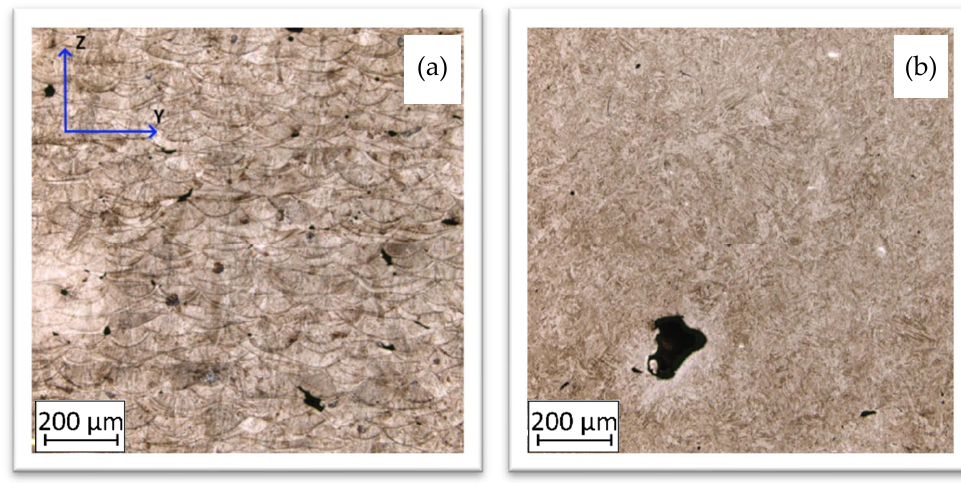
Figure 7. Microstructure of the AM M300 steel in BHT ( a ) and AHT ( b ) conditions. The material condition after the AM process is characterised by a typical, layered structure with visible molten pools [37,38]. The microstructure is very fine and regular in each molten pool, as is shown in Figure 8.